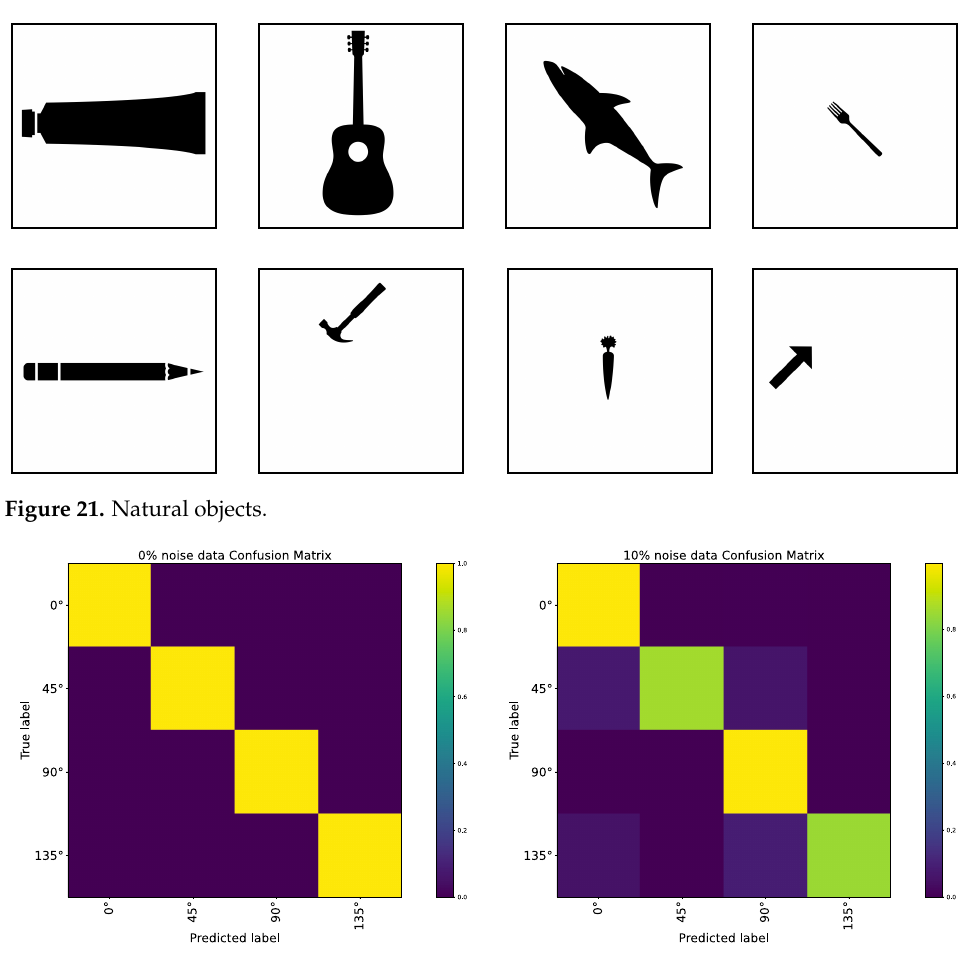
Figure 22. Confusion matrix. Table 4. The recognition accuracy of AVS and CNN on natural object